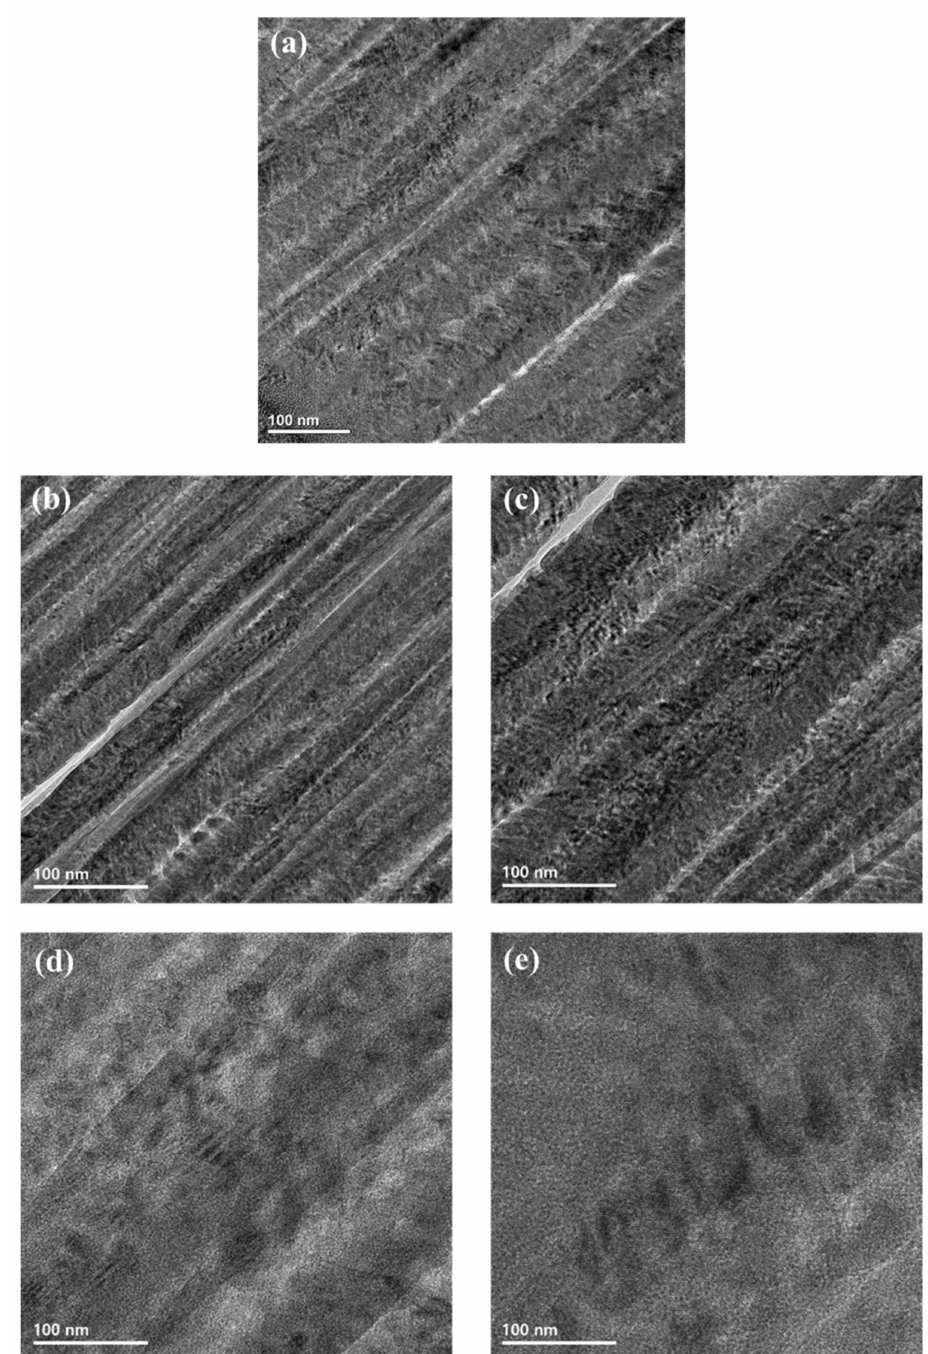
microstructure of carbon-doped SUS304 at 70%, 80%, 90%, and 100% laser output, respec- tively. In Figure 5b,c, the carbon-doped SUS304 has an ordered lattice structure due to the low laser output. However, in Figure 5d,e, a disordered lattice structure appeared due to high laser output, and it was confirmed that amorphization occurred in the carbon-doped SUS304 corresponding the Raman analysis.